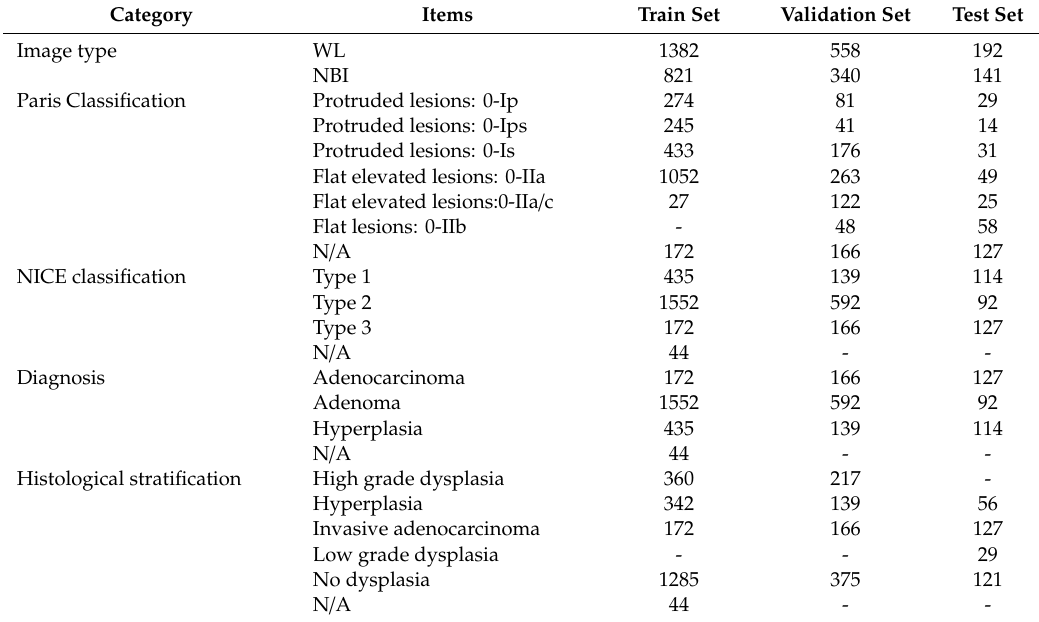
Table 2. Frames in each of the sets according to clinical